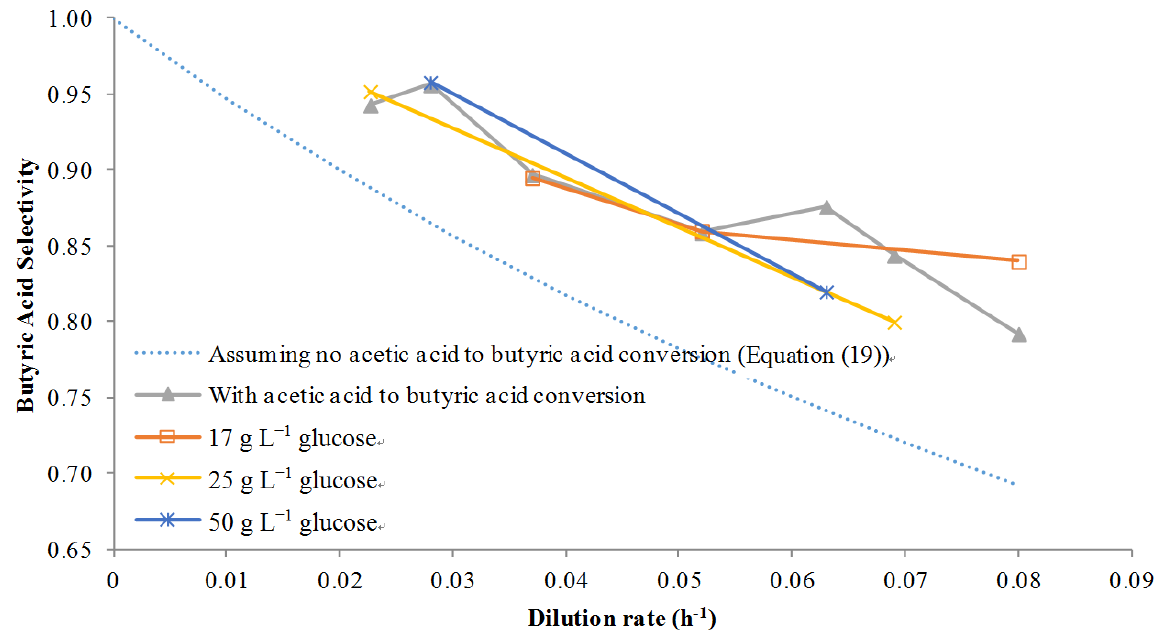
Figure 5. Comparison of experimental data and simulation of butyrate selectivity for continuous fermentation with Clostridium tyrobutyricum at pH of